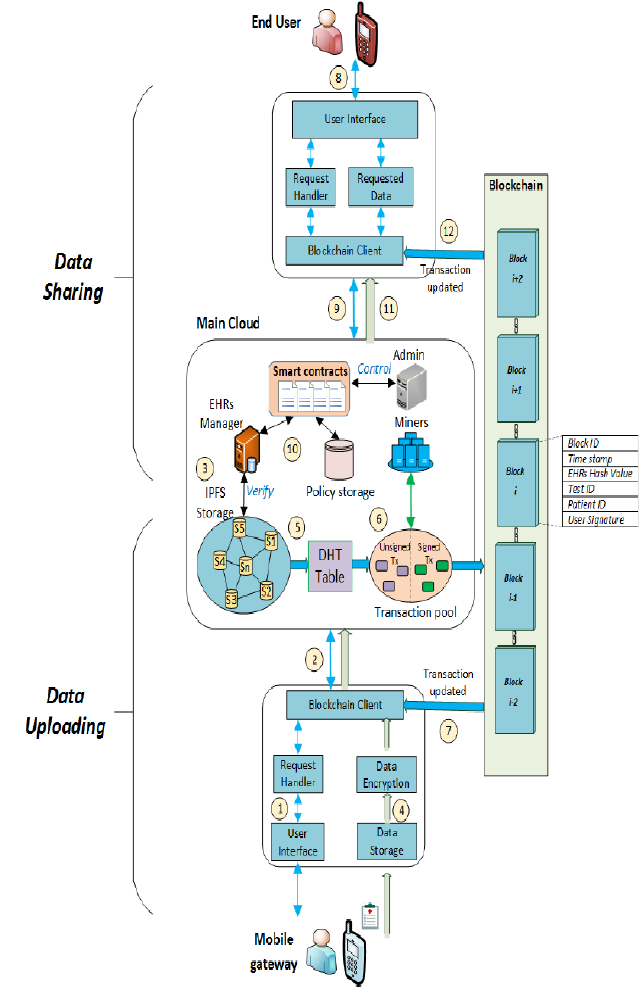
Figure (3). Multi-tier blockchain framework